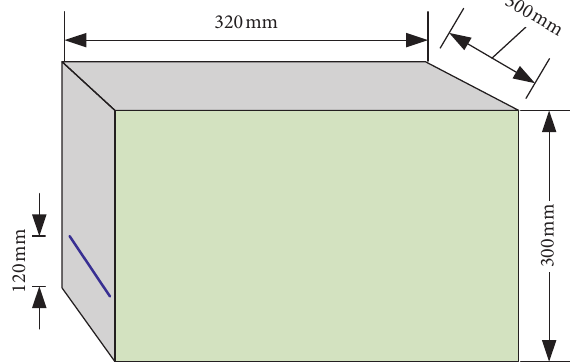
Figure 2: The schematic diagram of the test box.